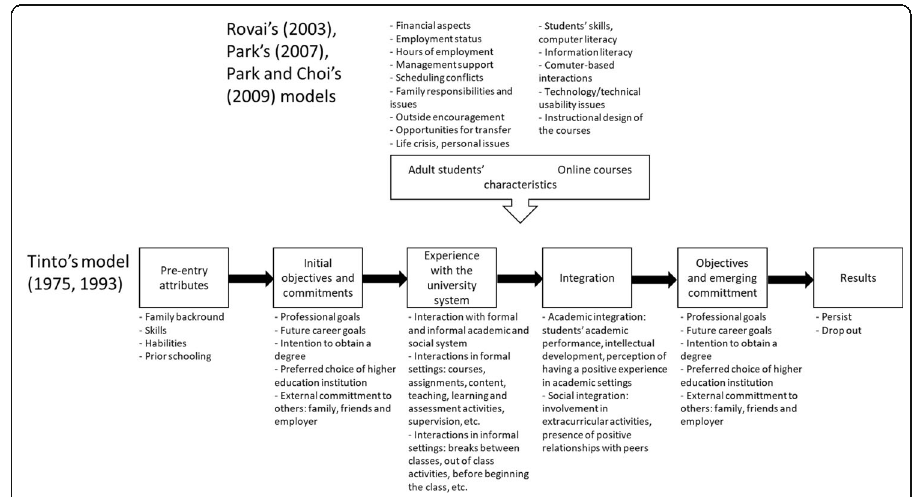
Fig. 1 Integrated persistence model from Park (2007), Park and Choi (2009), Rovai (2003) and